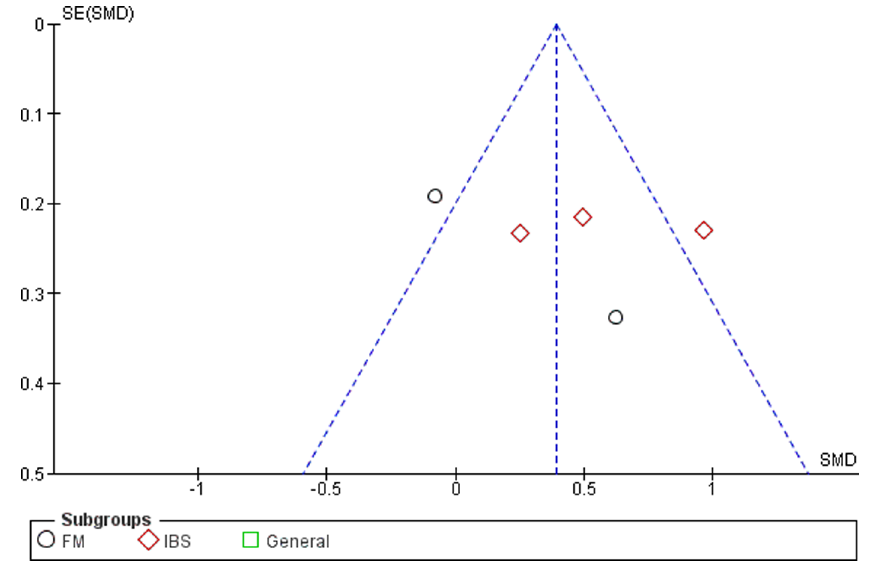
Figure 4. Funnel plot for quality of life.